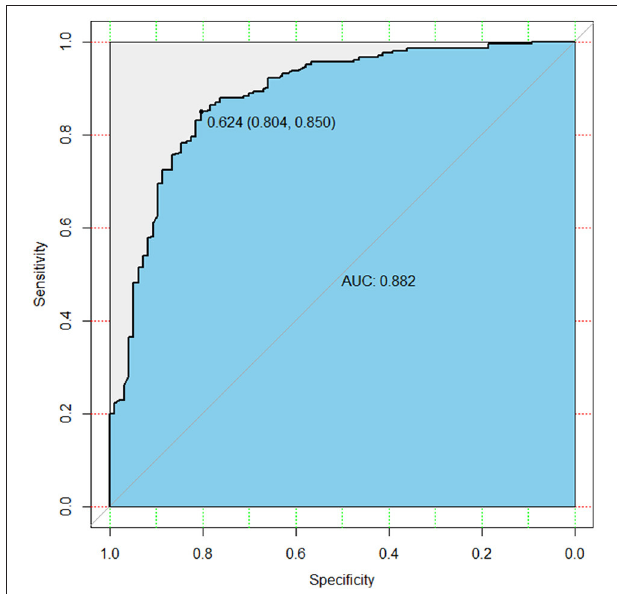
FIGURE 3 | The risk-adjusted model showed good discriminatory power (C-statistic = 0.882).